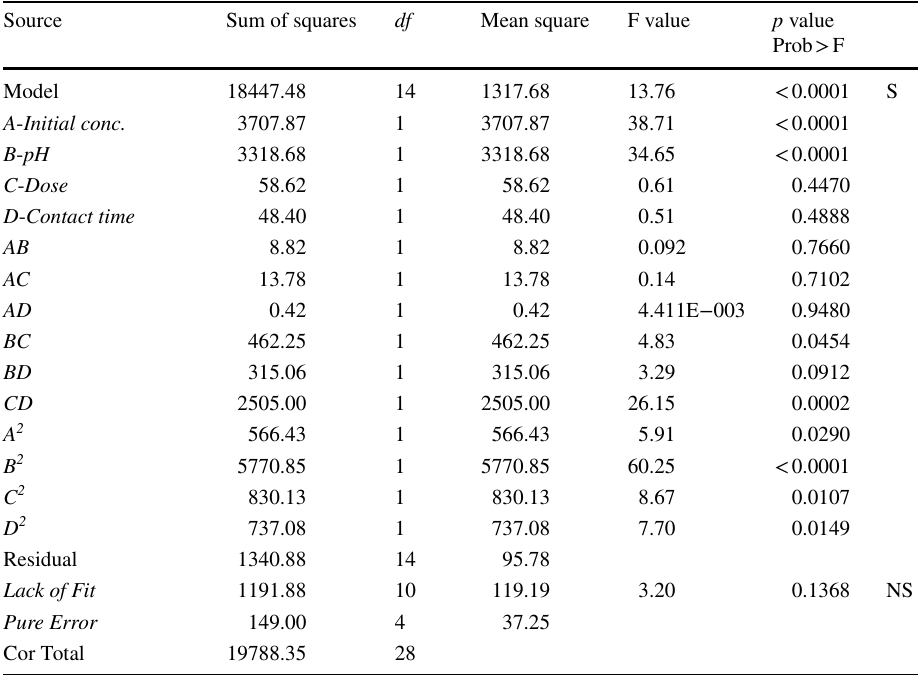
Table 4 ANOVA for Cr(VI) adsorption by mosambi